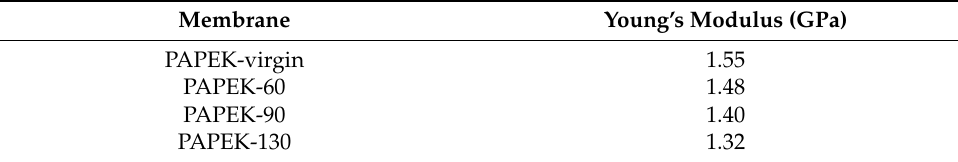
Table 2. Young’s modulus of PAPEK